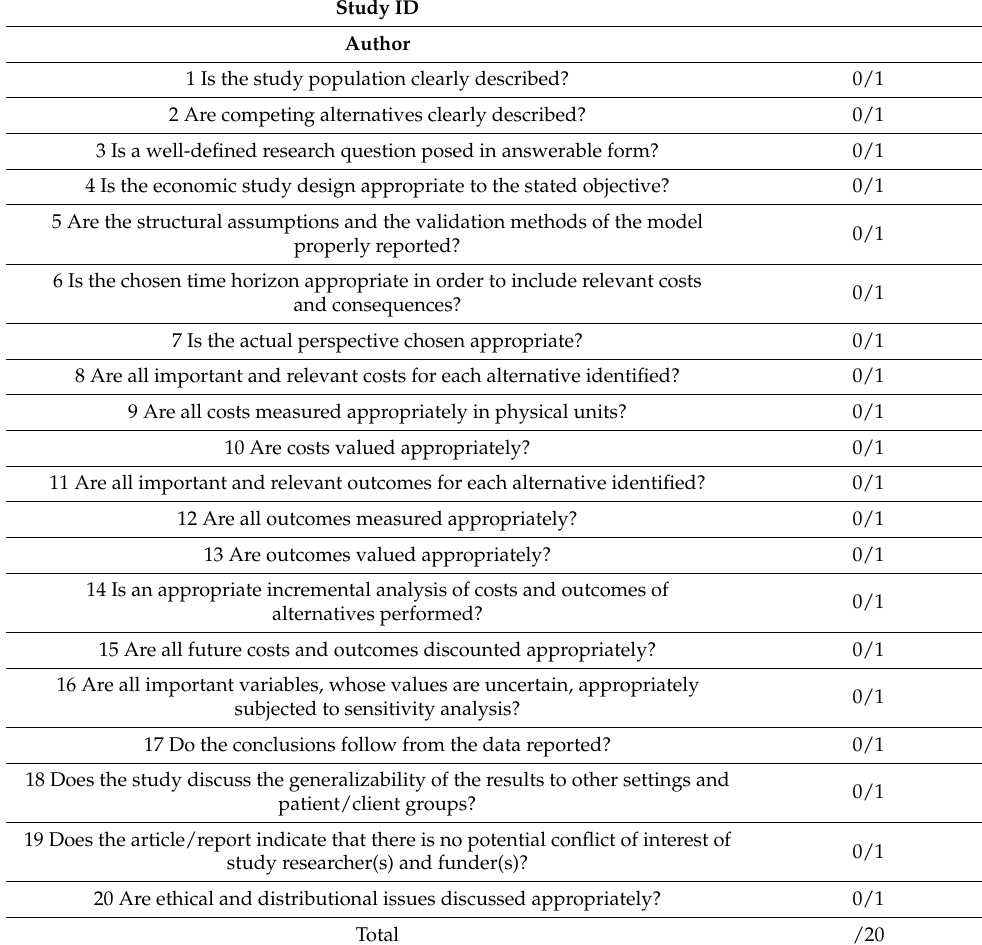
Table A3. Quality assessment form CHEC extended checklist